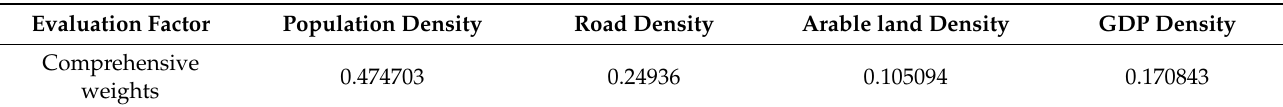
Table 9. Calculation results of objective weights of vulnerability assessment factors.